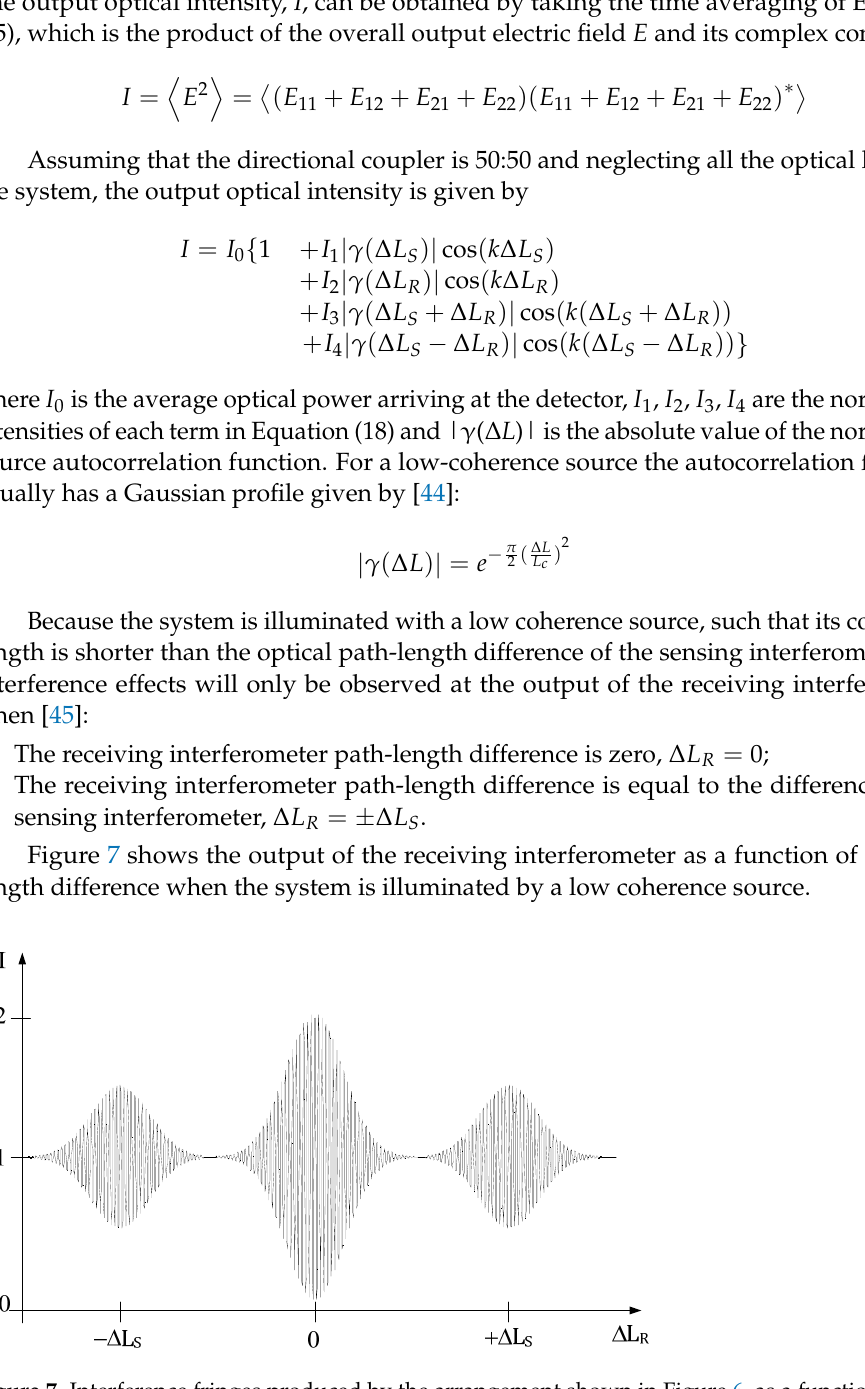
Figure 7. Interference fringes produced by the arrangement shown in Figure 6, as a function of L D in the receiving R